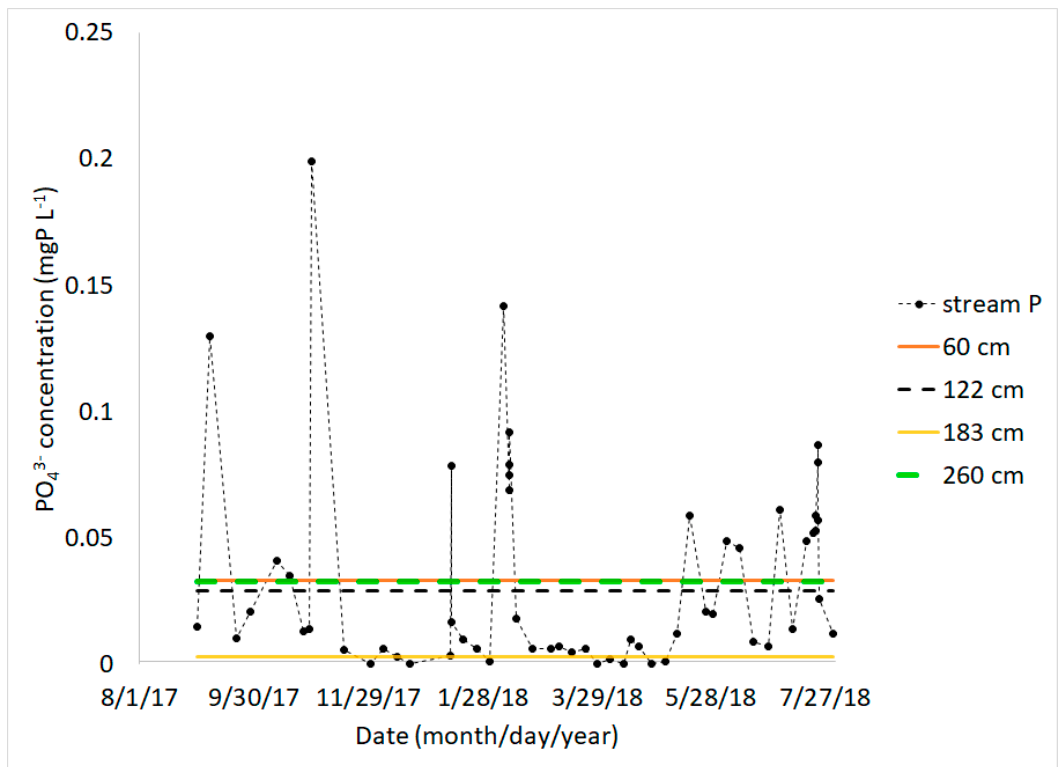
Figure 4 : Comparison of sediment EPC 0 values for four depths for stream bank site BEB against stream water PO 43 − concentrations over the period August 2017 to July 2018. Sediment sampling was done only one time in October–November 2017. EPC 0 values for four depths 60, 122, 183, and 260 cm from the top were 0.032, 0.028, 0.002, and 0.032, respectively.